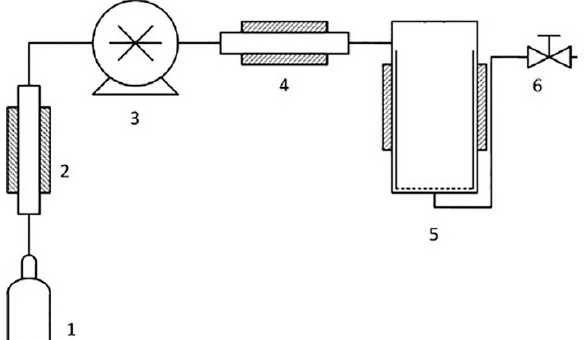
Figure 2. Equipment for the BMIm quaternization by PMP-Br in supercritical fluids (SCF) (1, source of CO 2 or CHF 3 ; 2, cooling heat exchanger; 3, high-pressure pump; 4, heater; 5, reactor; 6, pressure relief valve).